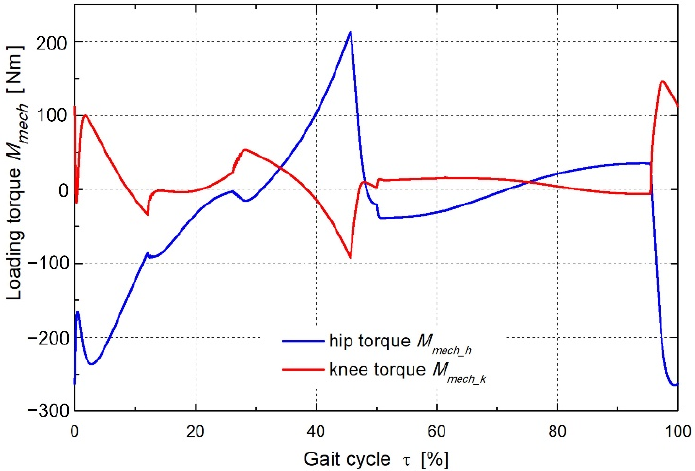
Figure 13. The load torque courses at the driven joints for steps with a length of l = 0.7 m. The courses of the required angular velocity at the driven joints for both step lengths are shown in Figures 14 and 15.